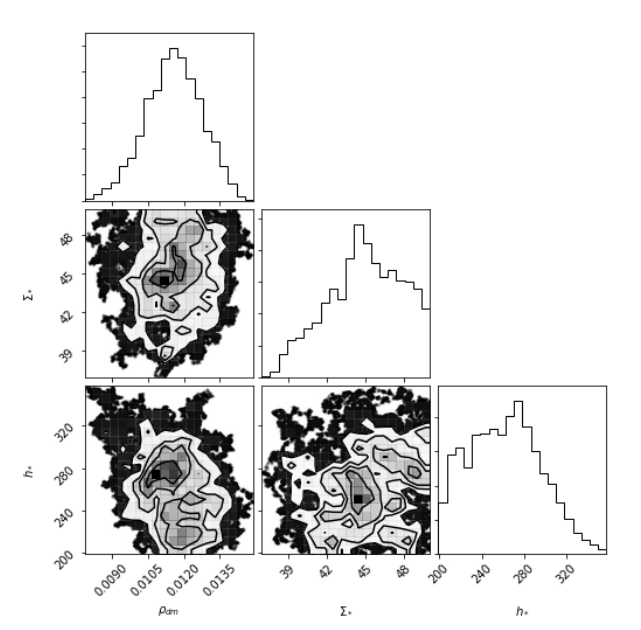
Figure 1. The marginalized posterior for the three free parameters. The units for ρ dm , Σ ∗ , and h ∗ are respectively M (cid:12) / pc 3 , M (cid:12) / pc 2 , and